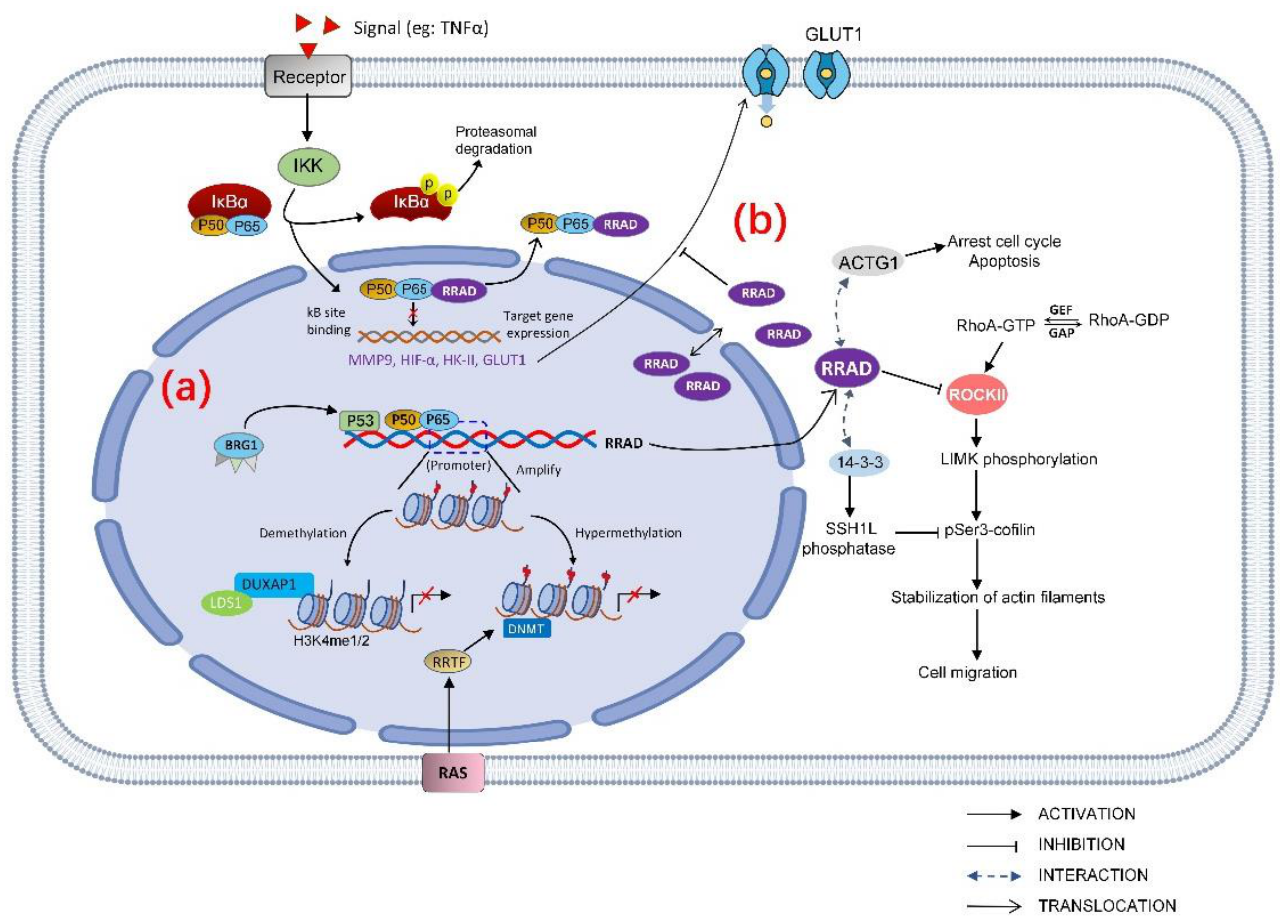
Figure 3. Regulation and downstream effectors of RRAD as a tumor suppressor gene. ( a ) RRAD regulation can be categorized as hypermethylation of the RRAD promoter, demethylation of the RRAD promoter region, and transcription factors modulated the RRAD gene, all of which eventually led to reduced RRAD expression. p53 and NF- κ B are transcription factors directly target RRAD. Detailed explanations are summarized in Table 1. ( b ) RRAD has various downstream effectors.